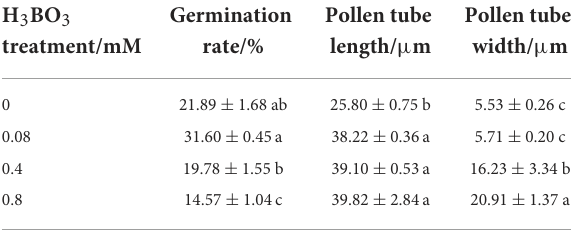
FrontiersinPlantScience